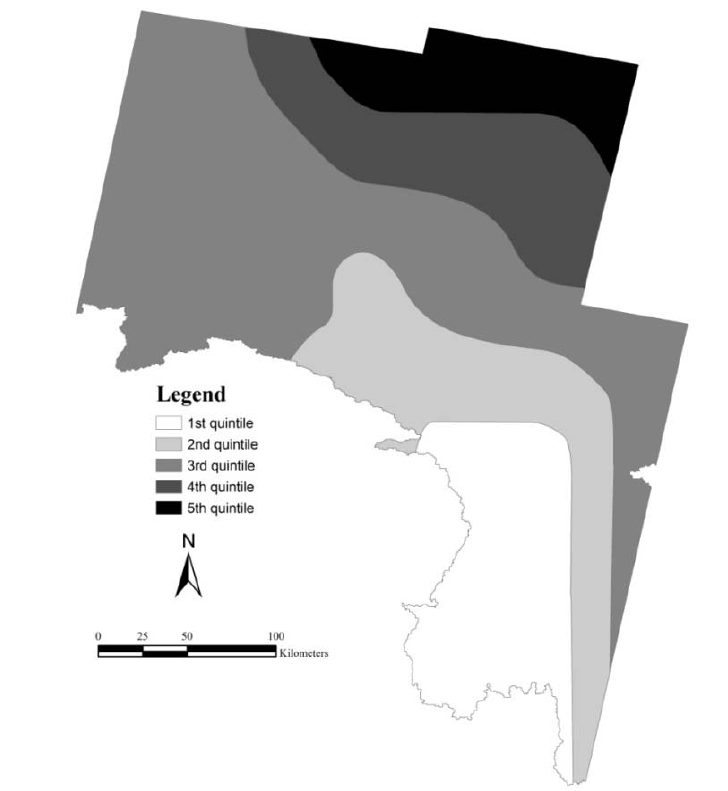
Figure 3. Precipitation regime classes based on precipitation quintiles calculated using the mean annual rainfall from 1972 to 2009. Actual range of data for each quintile (in order of 1–5) : 463.50mm to 523.57 mm, 538.93 mm to 582.2 mm, 575.03 mm to 582.21